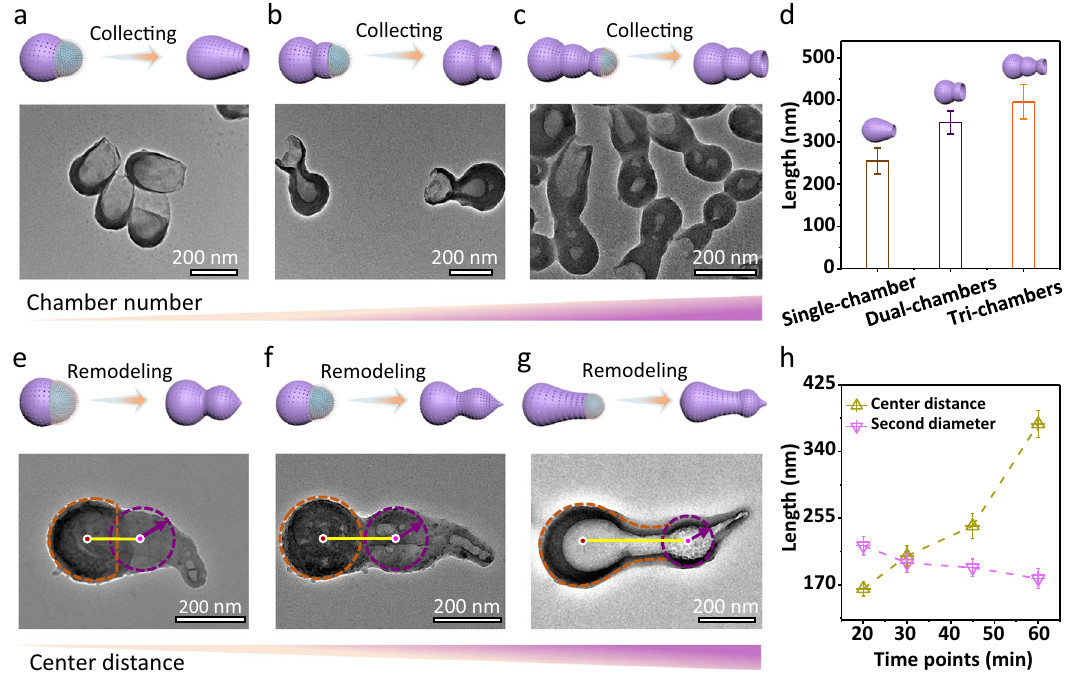
Fig. 3 | Hierarchical multi-chambered mesoporous nanoparticles with tunable openingandchamberdistribution.a – c Structuralmodels,TEMimages,and d the corresponding distribution histograms ofthe body length ofthe multi-chambered mesoporous nanoparticles with tunable openings; a single-chamber, b dual-